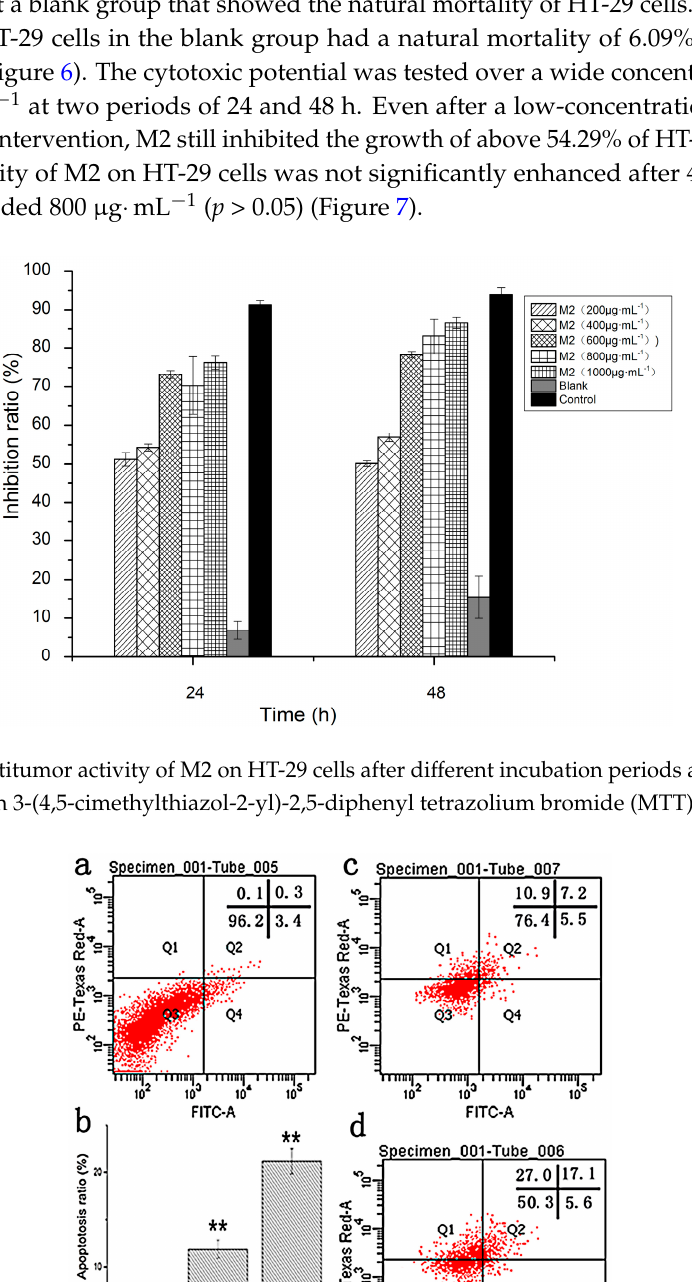
Figure 7. M2-induced apoptosis in HT-29 cells: ( a ) natural apoptosis of HT-29 cells without M2 (Blank) at 48 h on flow cytometry; ( c , d ) apoptosis of M2-treated cells at 24 and 48 h, respectively, on flow cytometry; and ( b ) bar graph summarizes the percentage of apoptosis. Data are expressed as mean ± SD of six replicate. **: p < 0.01.